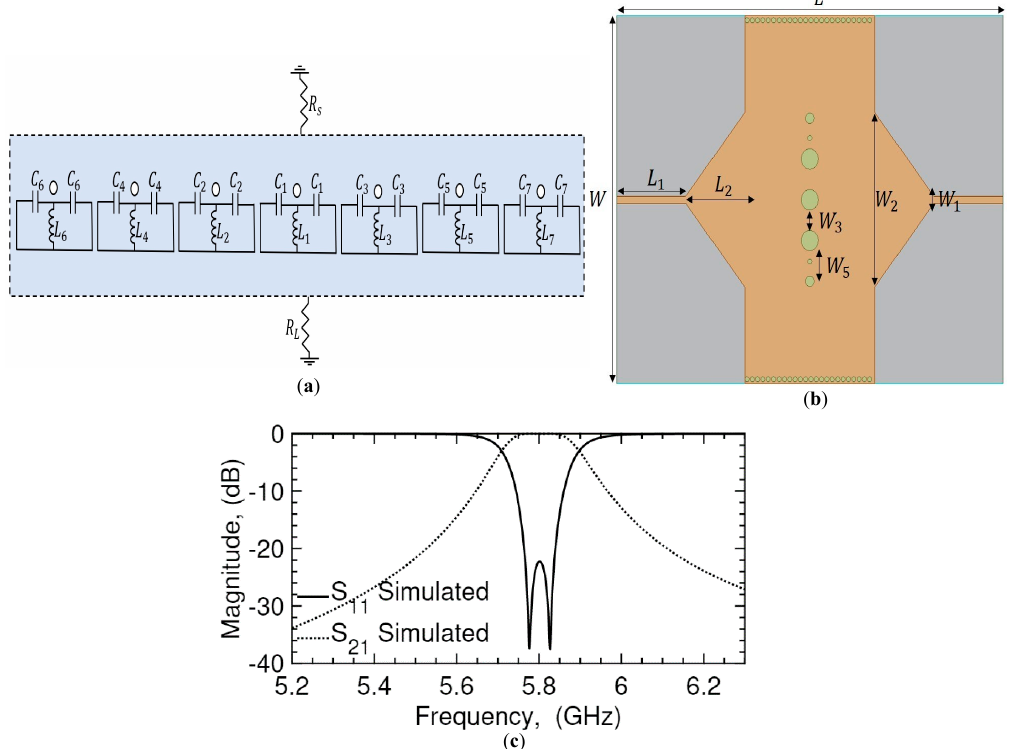
Figure 8. Simulated 5.8 GHz band silicon filter. ( a ) Equivalent circuit for 5.8 GHz filter. Each via corresponded to LC four-terminal element. R S and R L are equivalent resistance of source and load. ( b ) Schematic of proposed filter: W = 19.571 mm, W 1 = 0.4 mm, W 2 = 9.3 mm, W 3 = 1.1 mm, W 4 = 1.355 mm, L = 24.6 mm, L 1 = 4.4515 mm, and L 2 = 3.8 mm. ( c ) Simulated S-parameters.